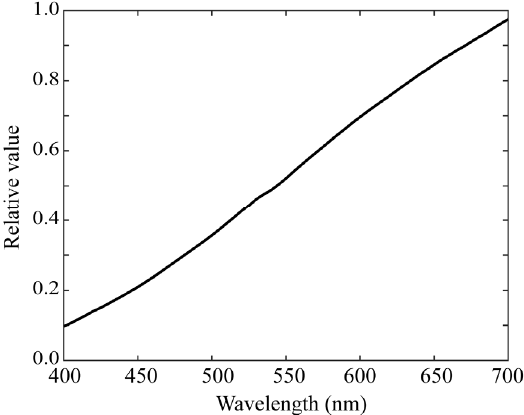
Figure 13. Spectral power distribution of the incandescent lamp used in an experiment on the single RGB-based spectral estimation.